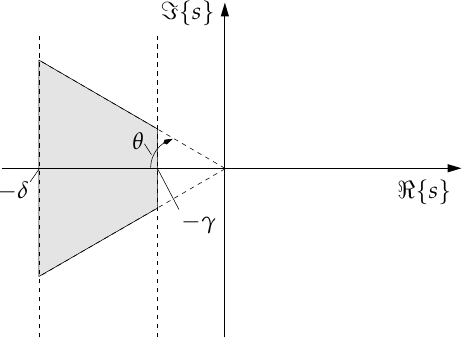
Figure 3. Domain of the eigenvalues compatible with the constraints (23) and (24), where θ = 0 is desired to guarantee non-oscillatory